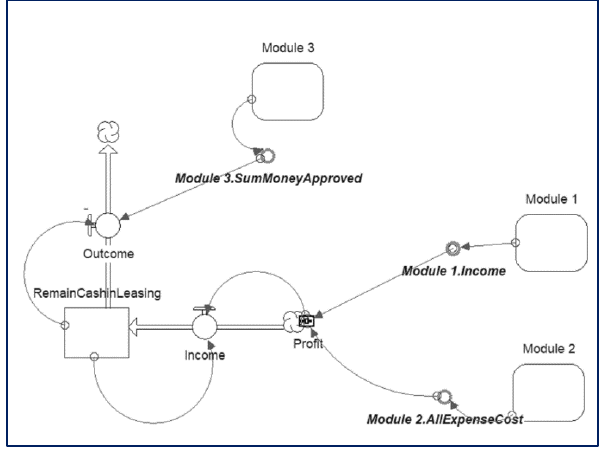
Figure 8. Profit model by system dynamics.